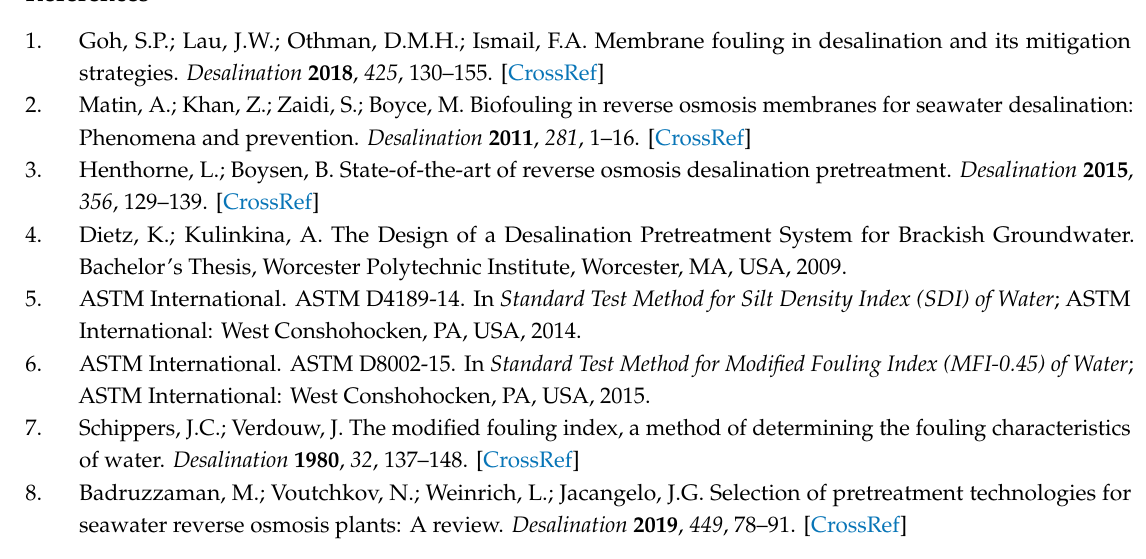
Figure S1: FEEM fluorescence features along the SWRO pre-treatment for seawater samples collected in August 2018, Figure S2: Hourly monitoring of microbial ATP concentrations for the seawater intake, after DAF, DMF1 and DMF2. Table S1: The e ff ect of antiscalant addition on BGP